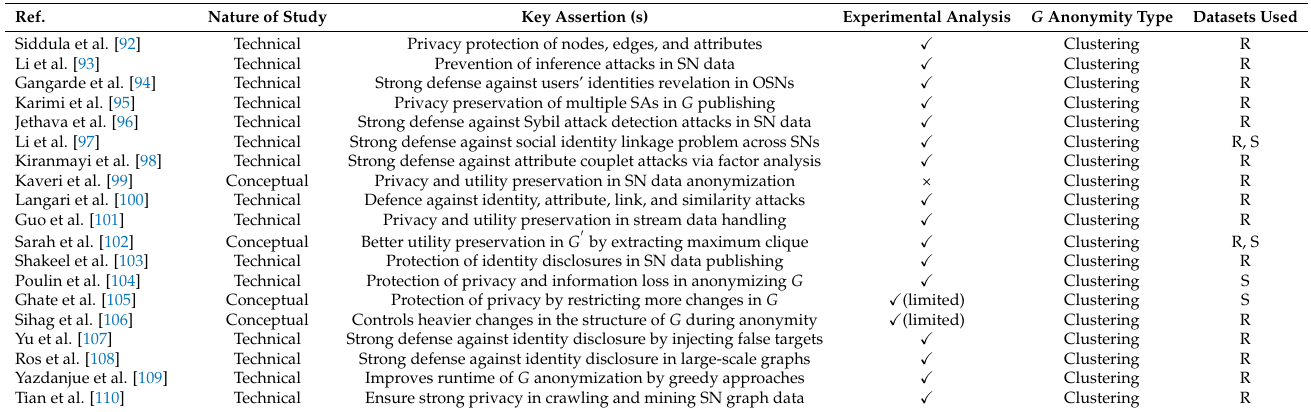
Table 4. Summary and comparison of state-of-the-art graph clustering-based